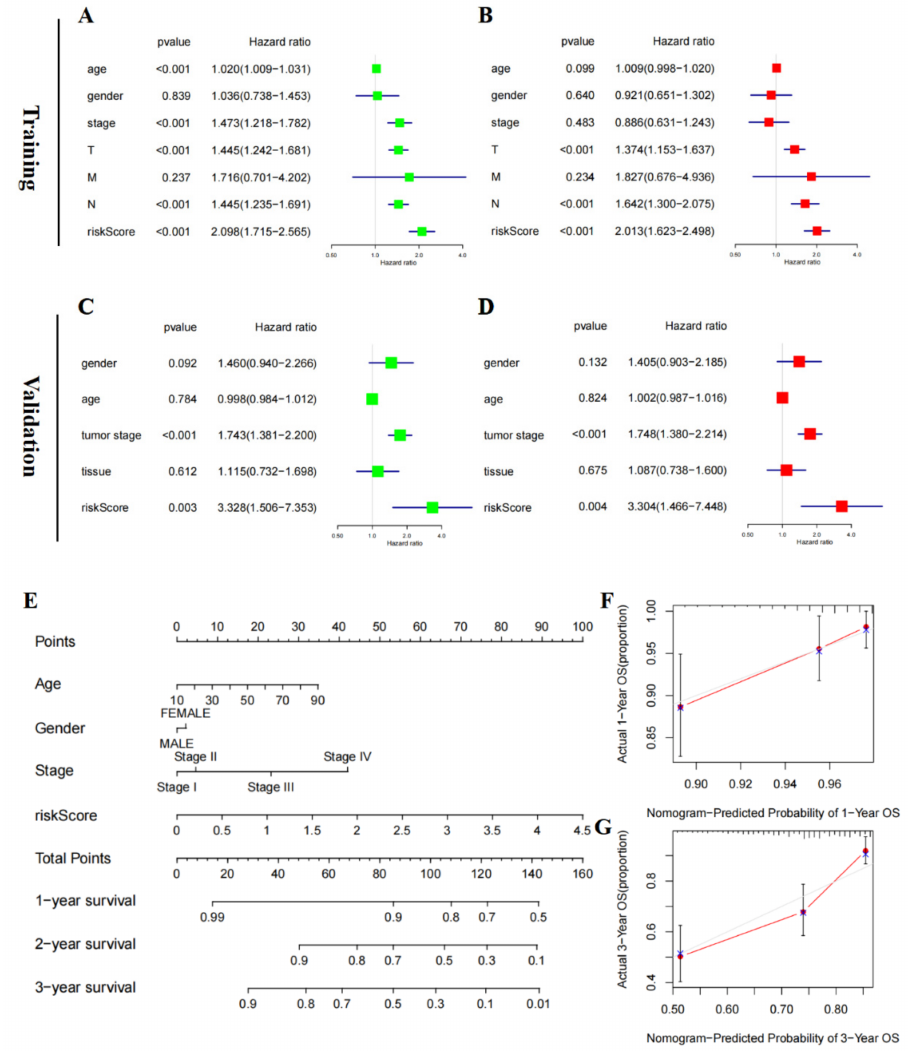
Figure 6. Independent prognostic factors in the validation and training cohorts. ( A , B ) Univariate and Multivariate Cox analyses of the risk score of our prognostic signature and clinicopathological parameters in the training cohort. ( C , D ) Univariate and Multivariate Cox analyses of the risk score of our prognostic signature clinicopathological parameters in the validation cohort. ( E ) Prognostic nomogram for malignant melanoma patients. ( F , G ) Calibration curves for the 1- and 3-year